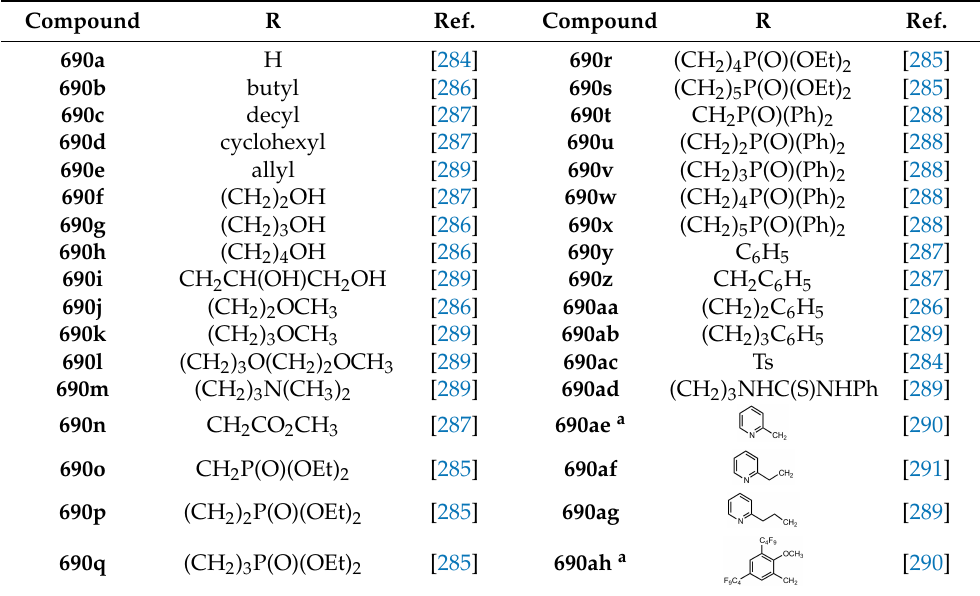
Table 2. A series of glucose-based aza-crown ethers synthesised by Bak ó and co-workers.